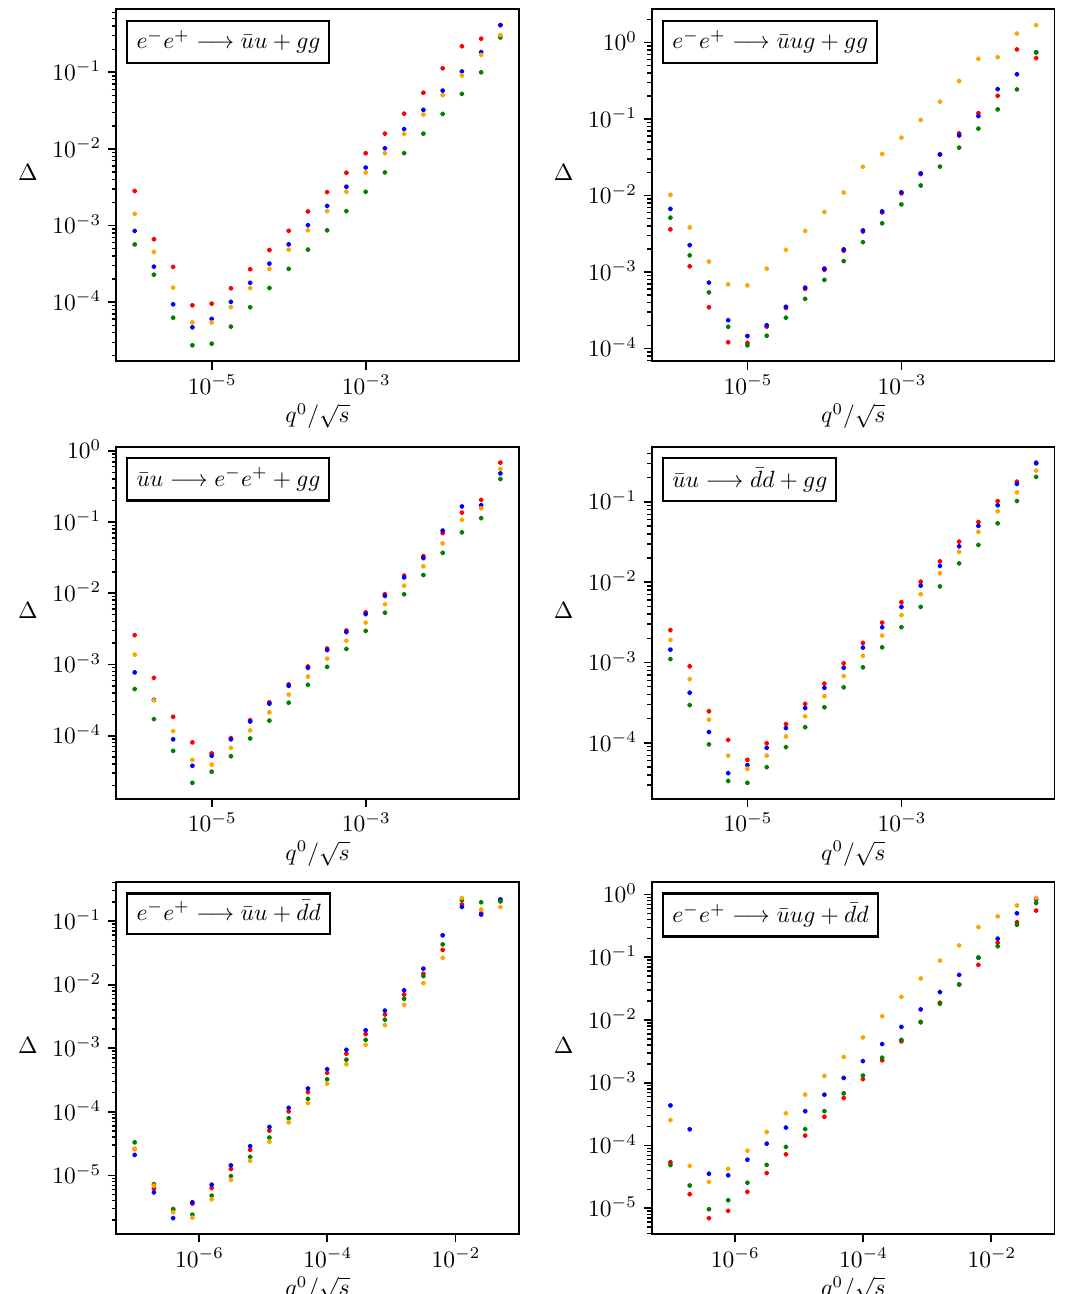
Figure 14 . Average of the relative error ∆ of the one-loop double-soft approximation against the energy q 0 of the soft partons. The energy is normalised with the center-of-mass energy process. The different colours correspond to different Born phase-space